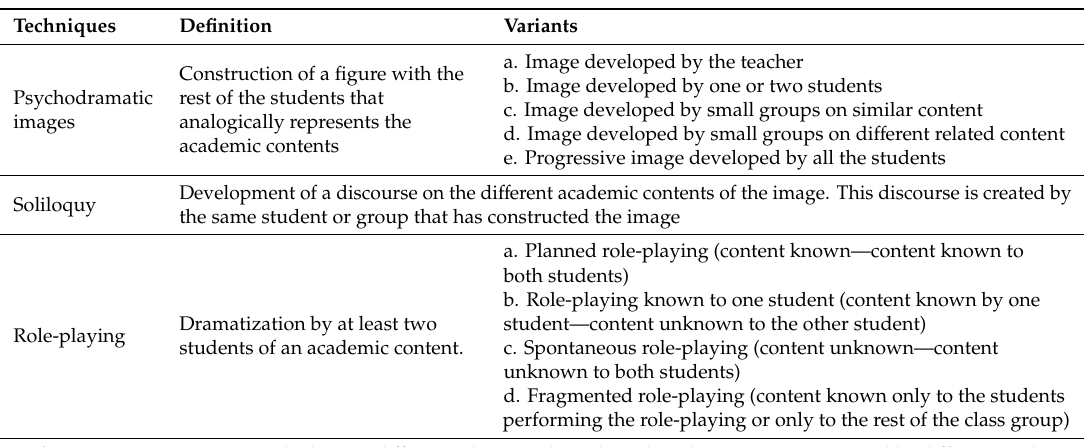
Table 1. Educational application of psychodramatic techniques.